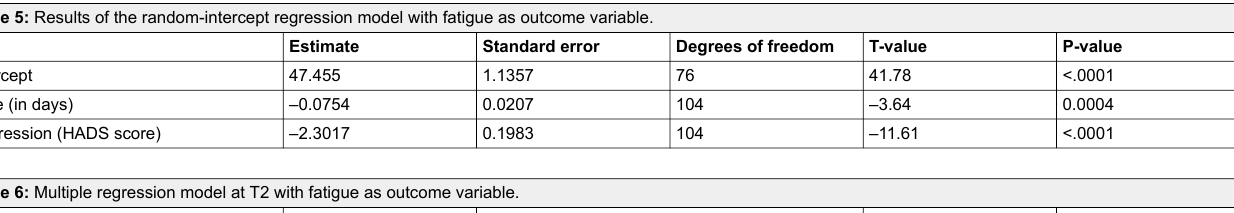
Table 5: Results of the random-intercept regression model with fatigue as outcome variable.